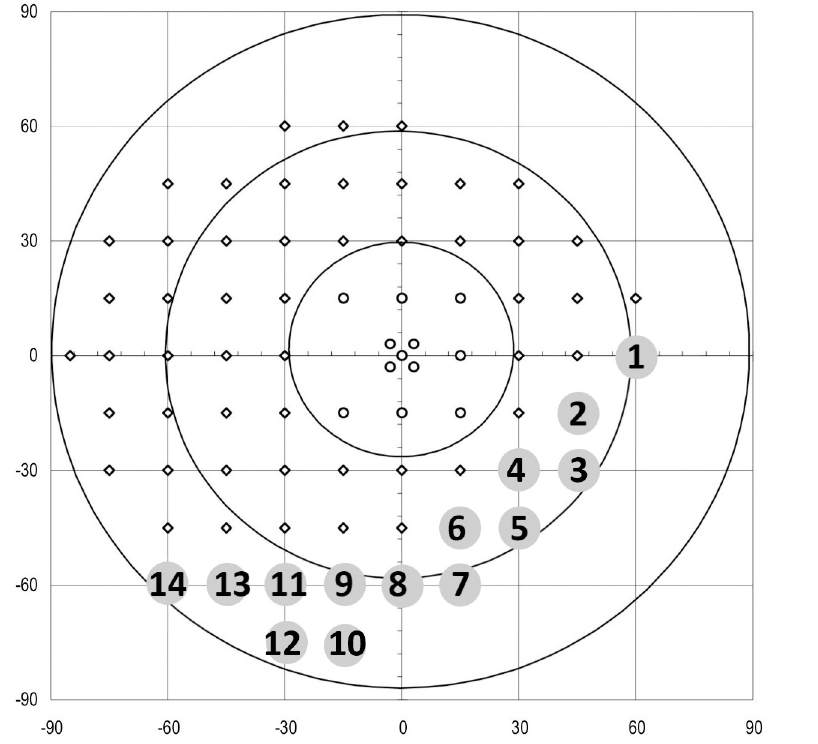
Fig 2. 90˚ perimetry, displaying the 14 defined